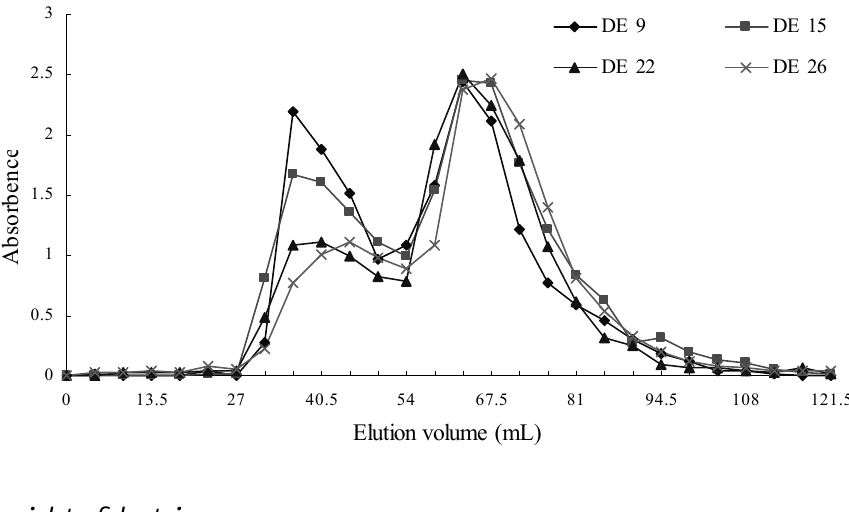
Figure 4. Elution profile on sephadex G 50 column of starch and